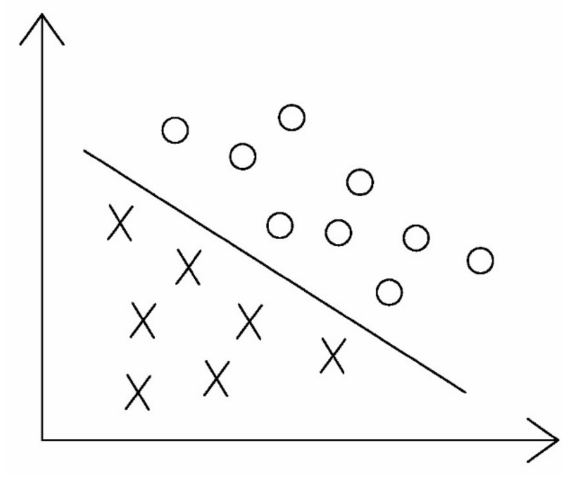
Figure 1. Hyperplane diagram in linear classification.